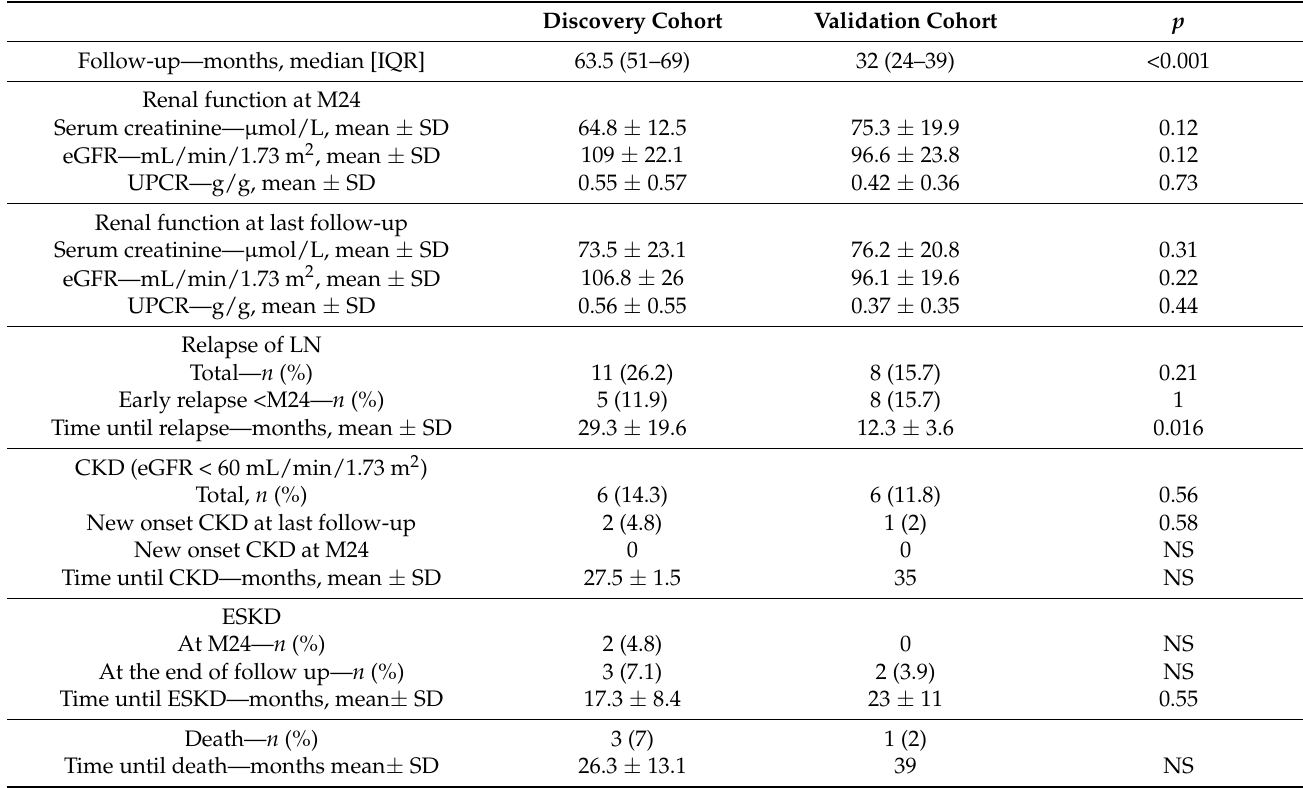
Table 2. Outcomes of patients from the discovery and validation